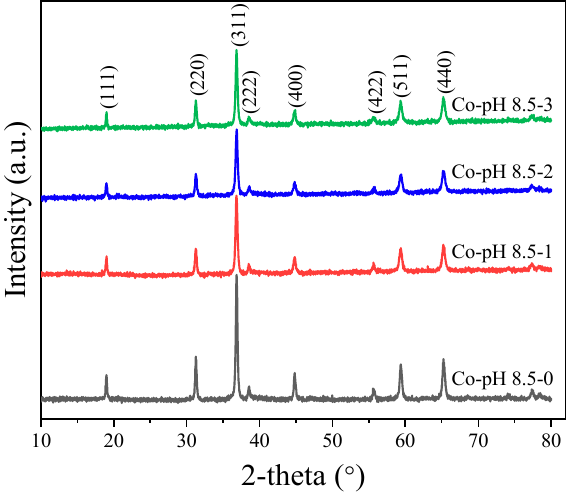
Figure 8. XRD patterns of cobalt oxides prepared at pH 8.5 with different number of washings. Table 3. Product yields, crystalline sizes, lattice constants and textural of cobalt oxides prepared at pH 8.5 with different number of washings.